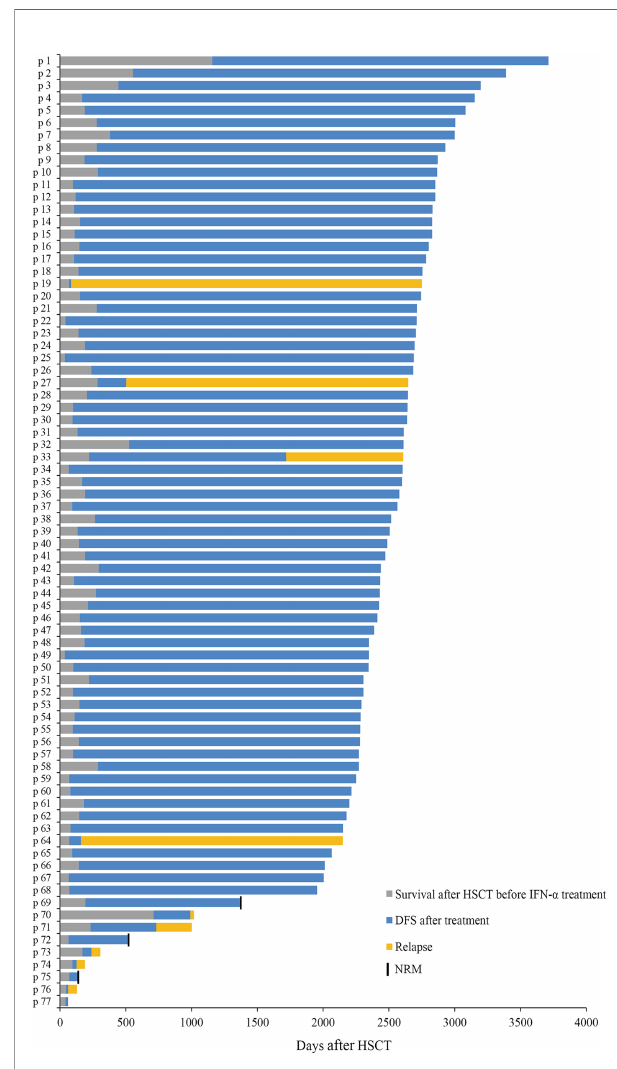
FIGURE 3 | Response. Swimmer plot displaying all patients who received preemptive IFN- a therapy after